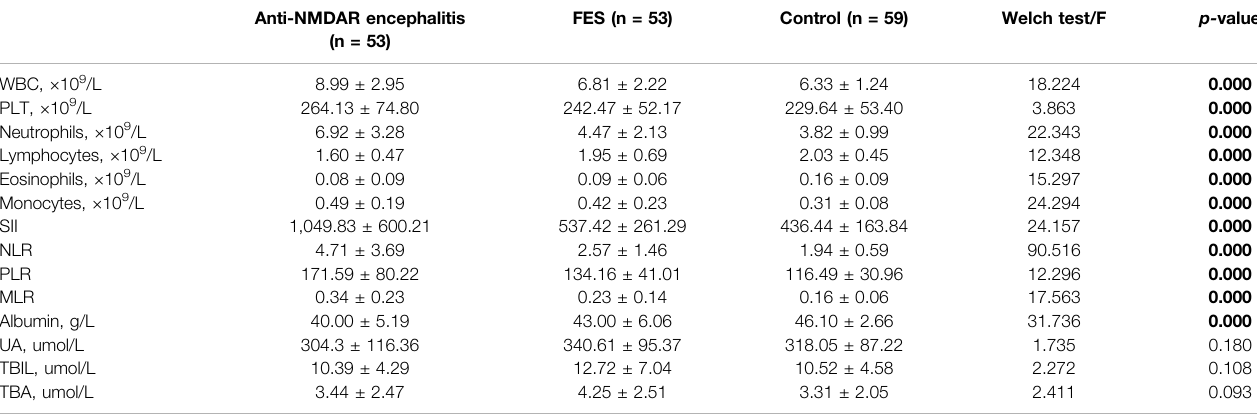
TABLE 2 | Comparison of factors in anti-NMDAR encephalitis, FES, and healthy individuals.